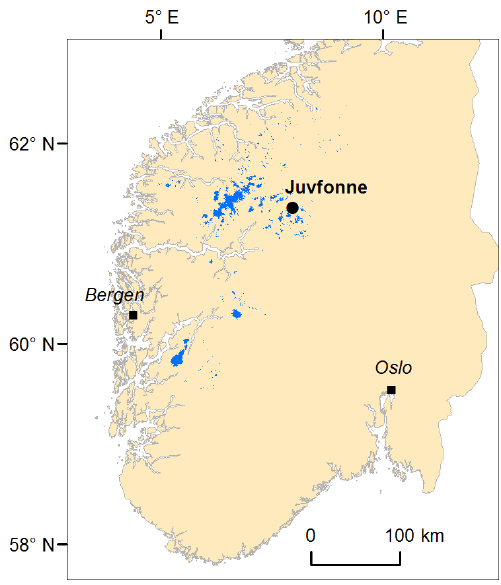
Figure 1. The field site Juvfonne in central southern Norway. Dark blue areas are